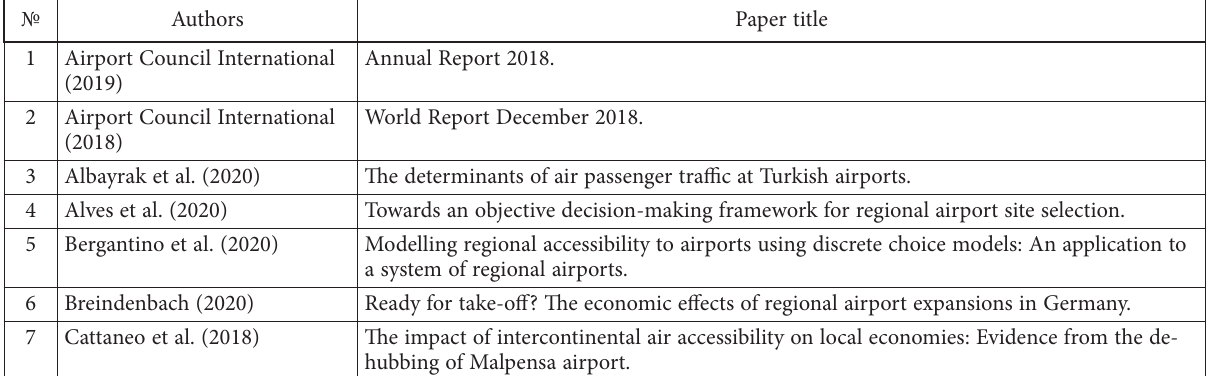
Table 2. A sample of sources selected for discourse analysis (created by the authors)